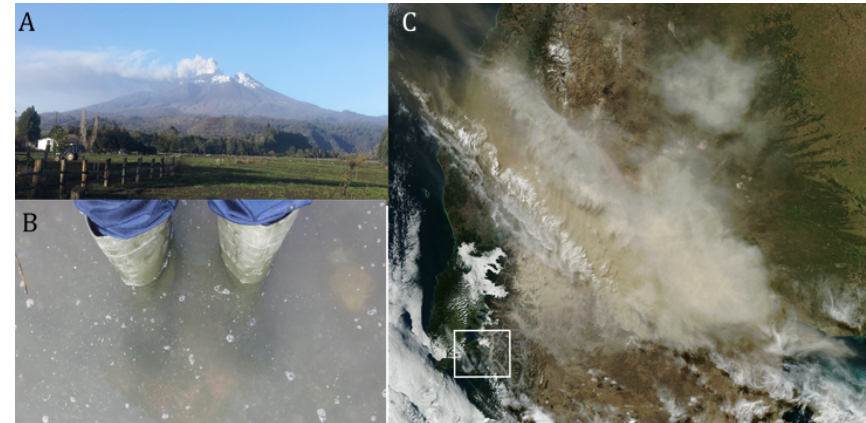
Figure 2. (a) Calbuco volcano ash plume 6 May 2015. (b) Reloncaví Fjord water with atypical high turbidity due to the ash loading, Cochamó town 6 May. (c) Ash cloud visible on MODIS Aqua satellite from the NASA Earth Observatory, 23 April (http://earthobservatory.nasa.gov/ NaturalHazards/view.php?id=85767&eocn=home&eoci=nh, last access: 1 February 2021). The highlighted box in panel (c) corresponds to Fig.